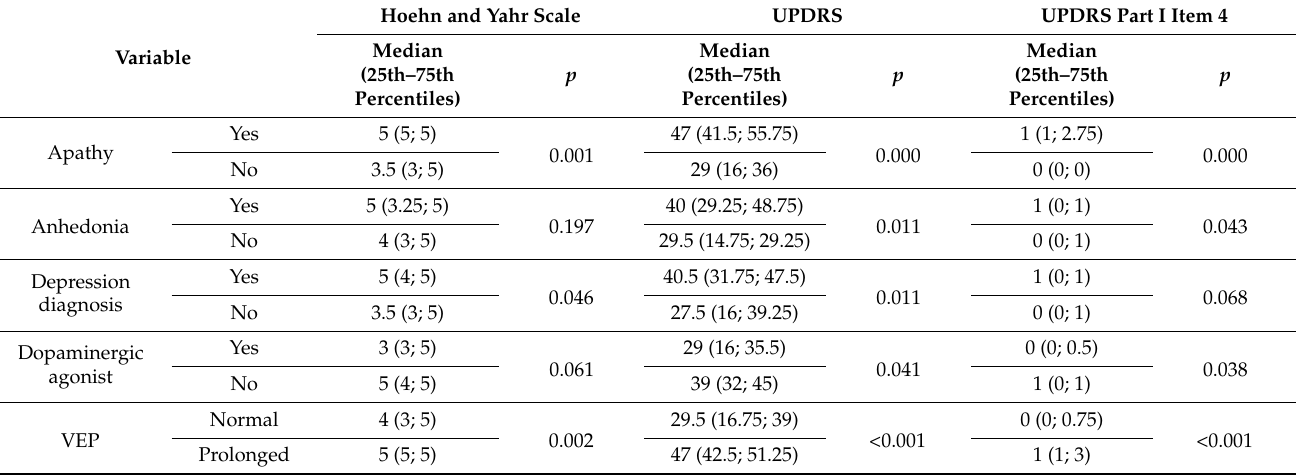
Table 4. Associations between disease scores and several